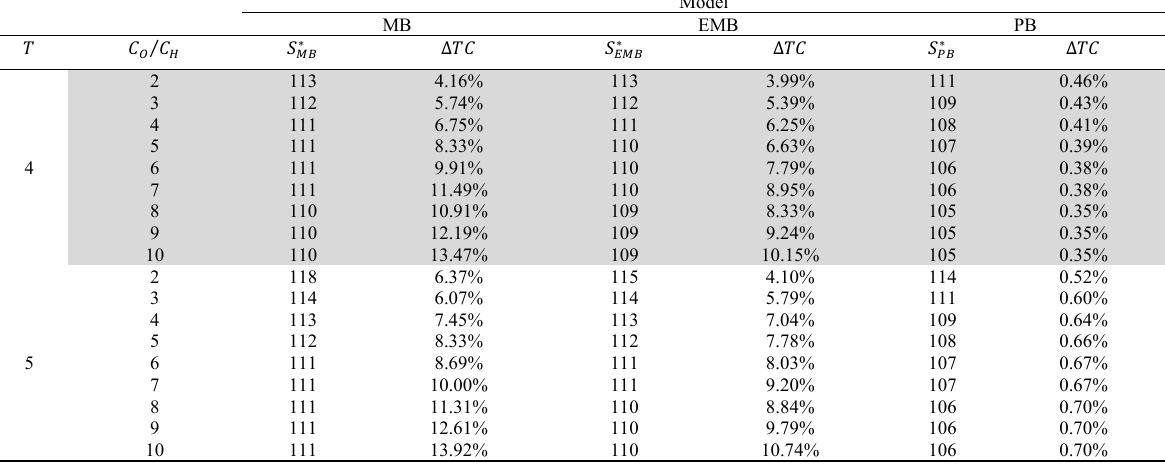
Performance of each model in comparison with simulation for the fast-moving product